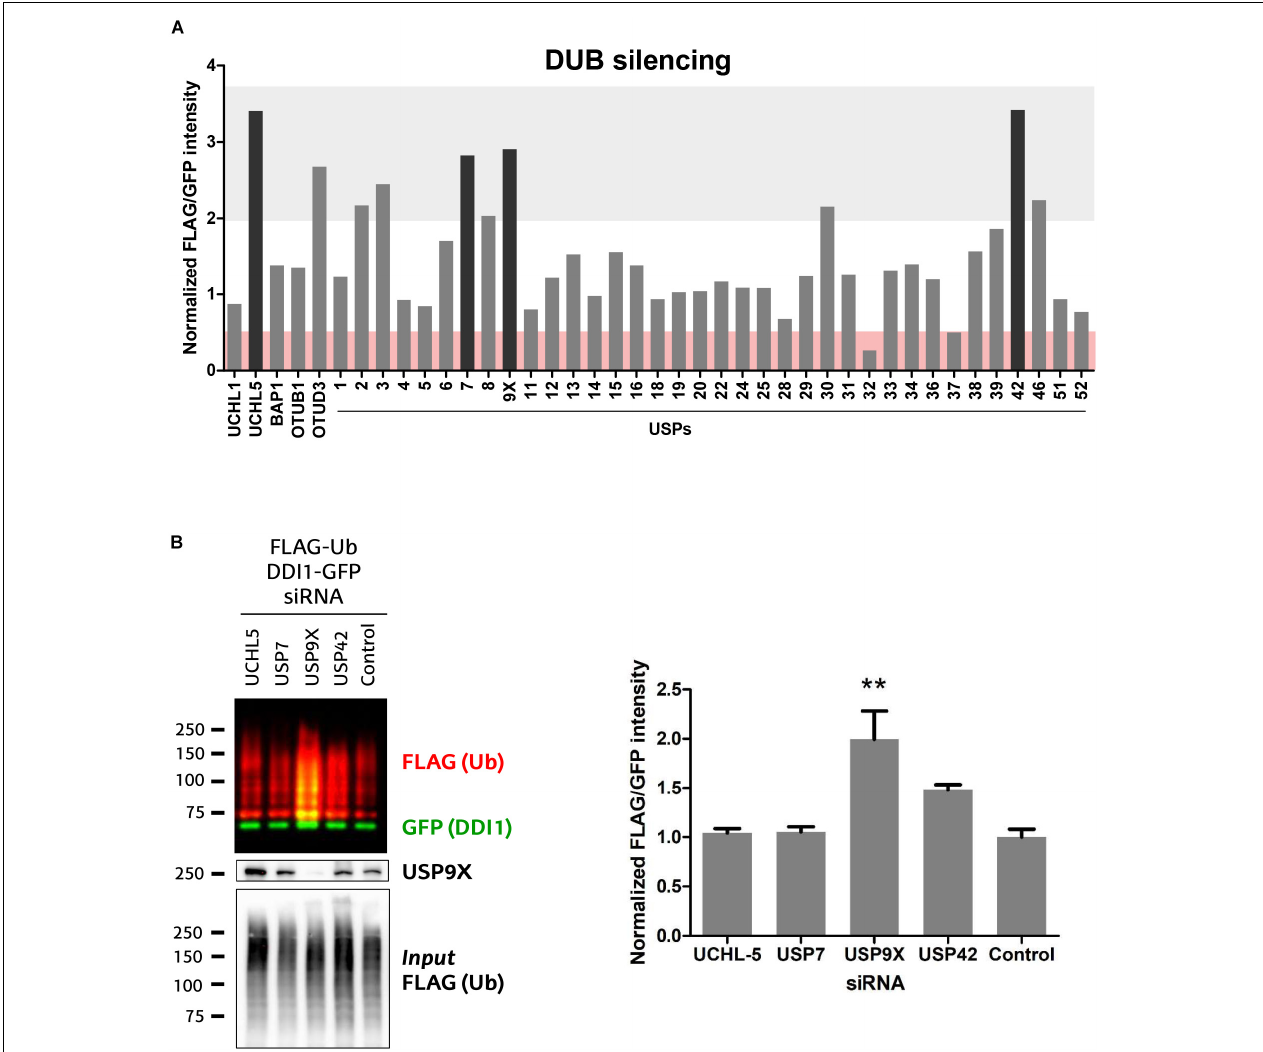
FIGURE 5 | Screen of 41 human DUBs indicates USP9X to be the counteracting DUB of UBE3A. (A) 41 different human DUBs were silenced using 10 nM siRNAi. After GFP-pulldown of DDI1-GFP, FLAG/GFP intensity ratios were determined. Those ratios were normalized to the average of three lowest values on each 6-well experimental dataset. Upon silencing of most DUBs, the ubiquitination of DDI1 did not change quantitatively (0.5 < fold-change < 2, white). However, silencing of some DUBs decreased DDI1 ubiquitination (fold-change < 0.5, red), while some others increased it (fold-change > 2, gray). Black bars highlight the DUBs that affect more severely DDI1 ubiquitination (UCHL-5, USP7, USP9X, and USP42). (B) siRNAs were used to silence UCHL-5, USP7, USP9X, and USP42 DUBs and scramble siRNAi was used as a control. After GFP-pulldown, DDI1 ubiquitination was detected by western blot analysis using anti-FLAG (red) and anti-GFP (green) antibodies. Equivalent amounts of ectopically overexpressed ubiquitin was detected in the cell lysates [ Input FLAG-(Ub)], while USP9X silencing was corroborated by anti-USP9X antibody (USP9X). Quantification was performed with Image-J after normalizing FLAG/GFP intensities. USP9X inhibition significantly enhanced DDI1 ubiquitination [one-way ANOVA, ∗∗ p -value < 0.05, (mean ± S.E.M., n = 3)]. DDI1 ubiquitination also increased upon USP42 silencing, but not significantly, while no changes were observed for the UCHL-5 and USP7 experiments.